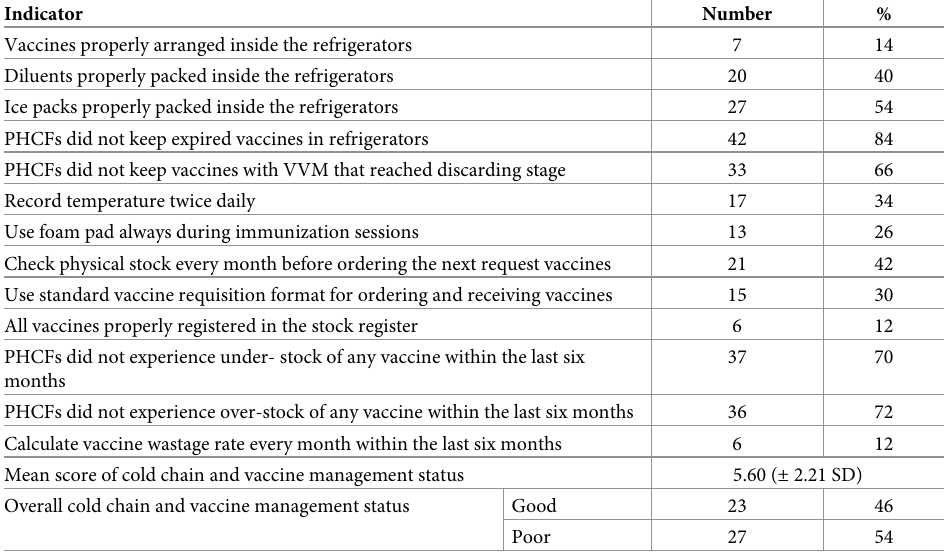
Table 3. Cold chain and vaccine management status in primary health care facilities of Tigray region, Northern Ethiopia, 2019, (N = 50).